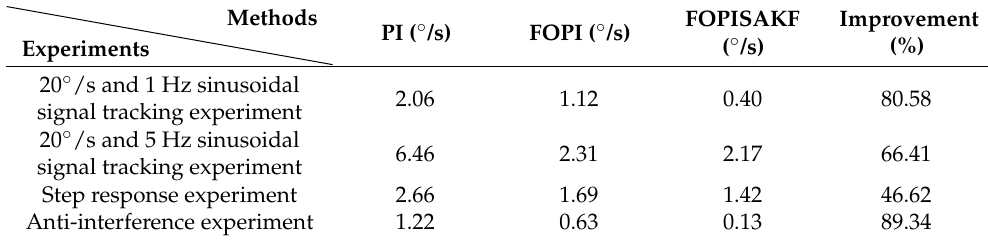
Figure 6. Performance comparison under different methods. ( a ) 20°/s&1Hz sinusoidal signal tracking experiment. ( b ) 20°/s&5Hz sinusoidal signal tracking experiment. ( c ) Step response experiment. ( d ) Anti-interference experiment. Table 2. The RSME of experiments under different methods.